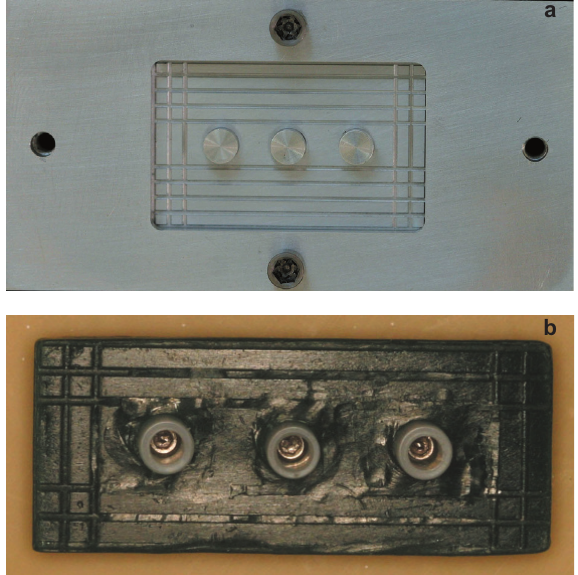
Figure 3a and 3b- Component 1 and component 2 used for reproduction of the wax-up and wax patterns under polyurethane block